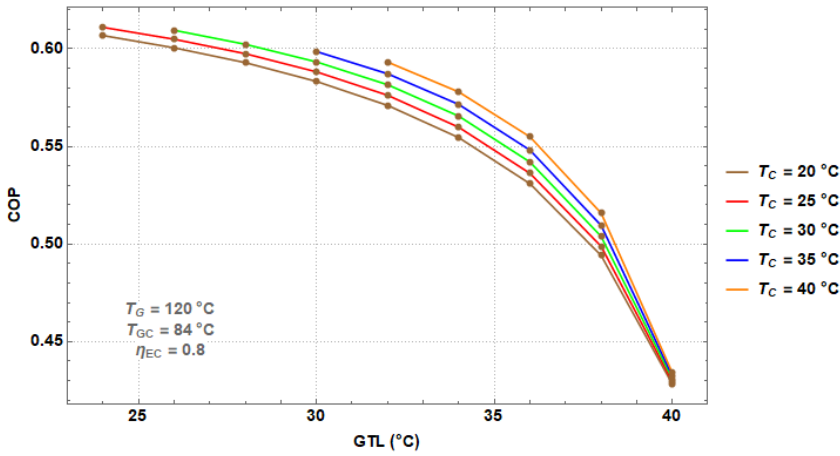
Figure 5. COP as a function of GTL at different T C values for the DEHT.